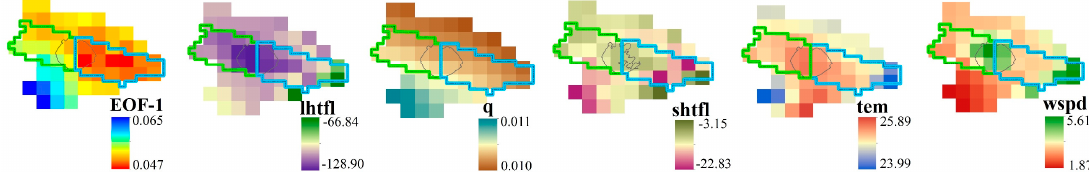
Figure 11. Annual average spatial distribution of climatic factors in flood season from 1979 to 2016.